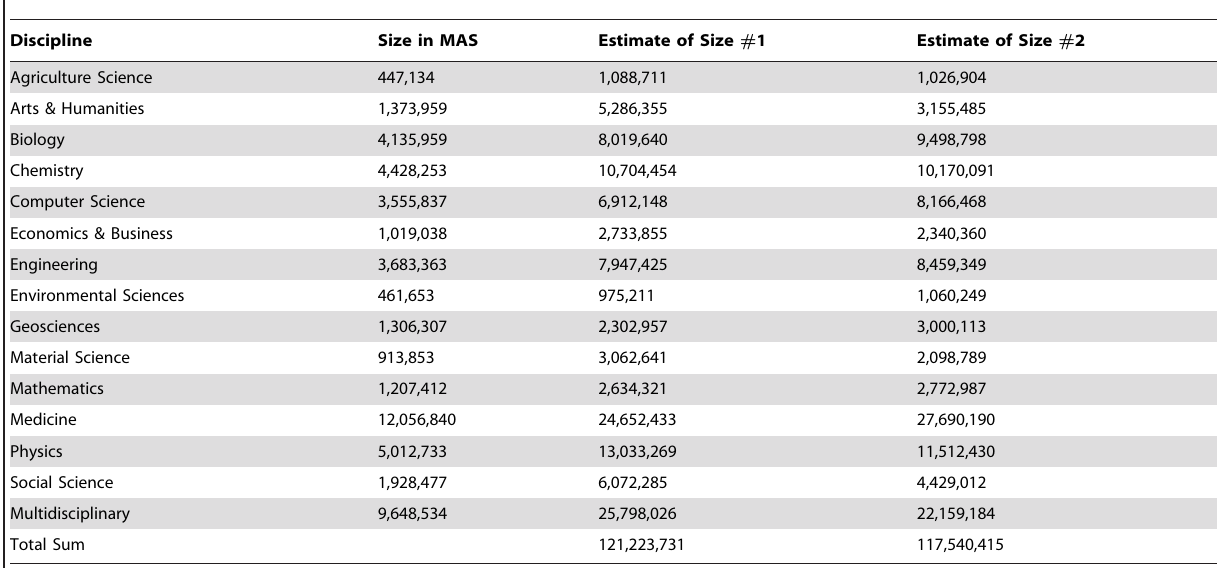
Table 1. The estimated number of documents on the web for each